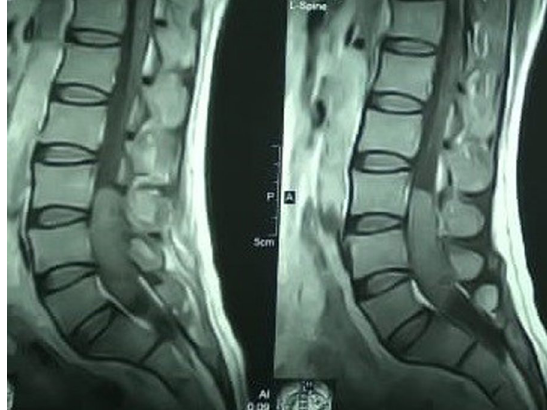
Fig. 3 Well-circumscribed intradural mass at the L3–S1 level with no contrast